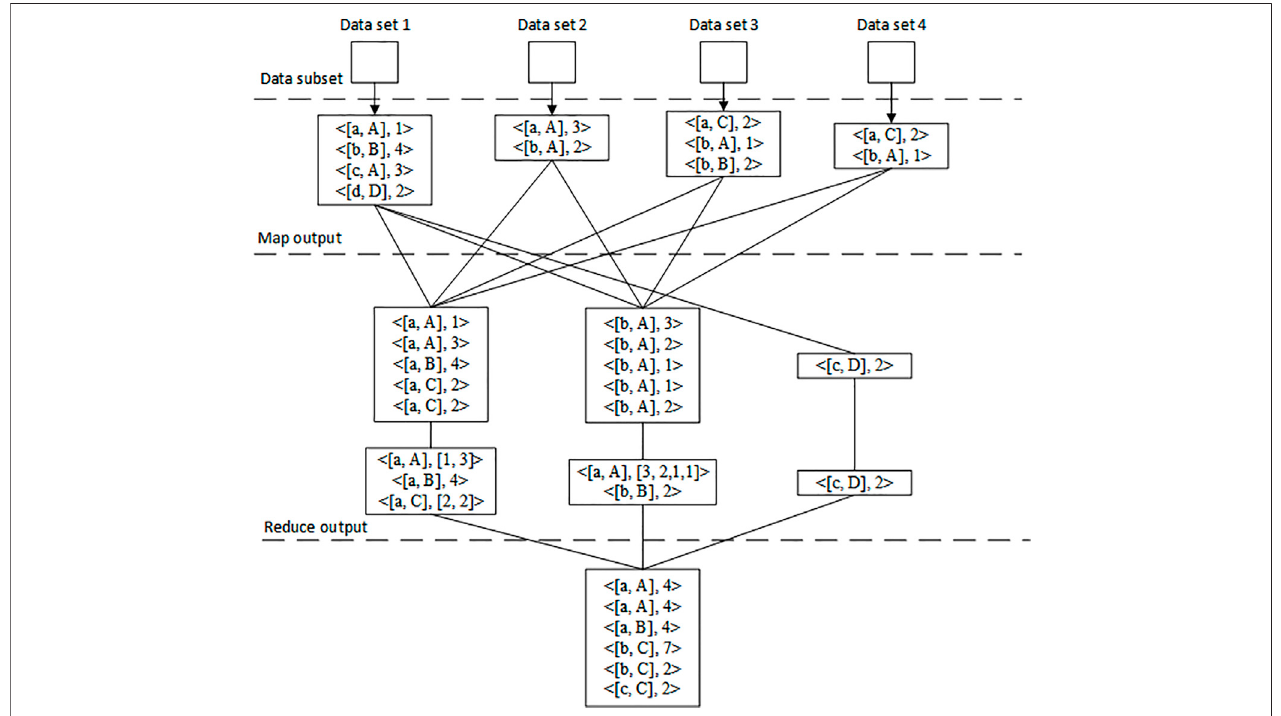
FIGURE 2 | MapReduce data statistics process